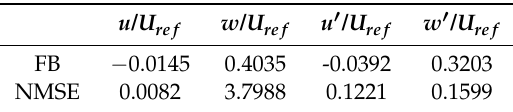
Table A4. FB and NMSE between experiment and simulation for the case with a reversed wind catcher in Section 4.3.